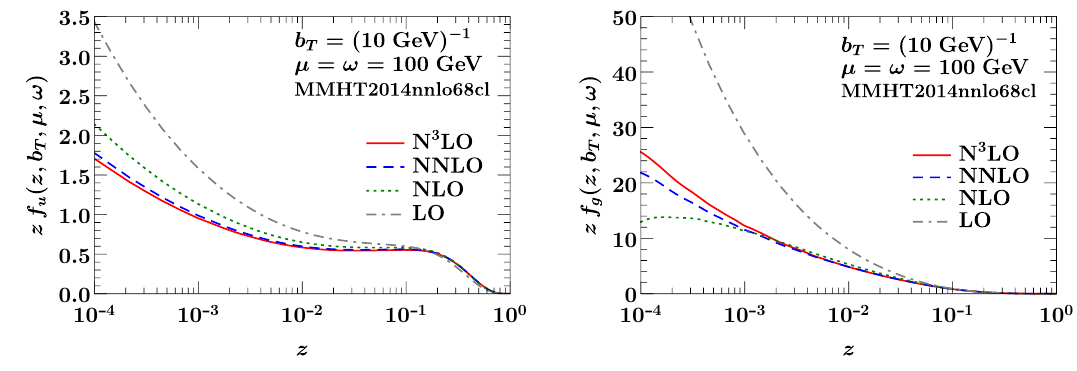
Figure 2 . The u -quark TMDPDF (left) and the gluon TMDPDF (right) as a function of z for (cid:12)xed b T = (10 GeV) (cid:0) 1 and (cid:22) = ! = 100 GeV. We show the result at LO (which corresponds to the PDF), NLO, NNLO and N 3 LO.